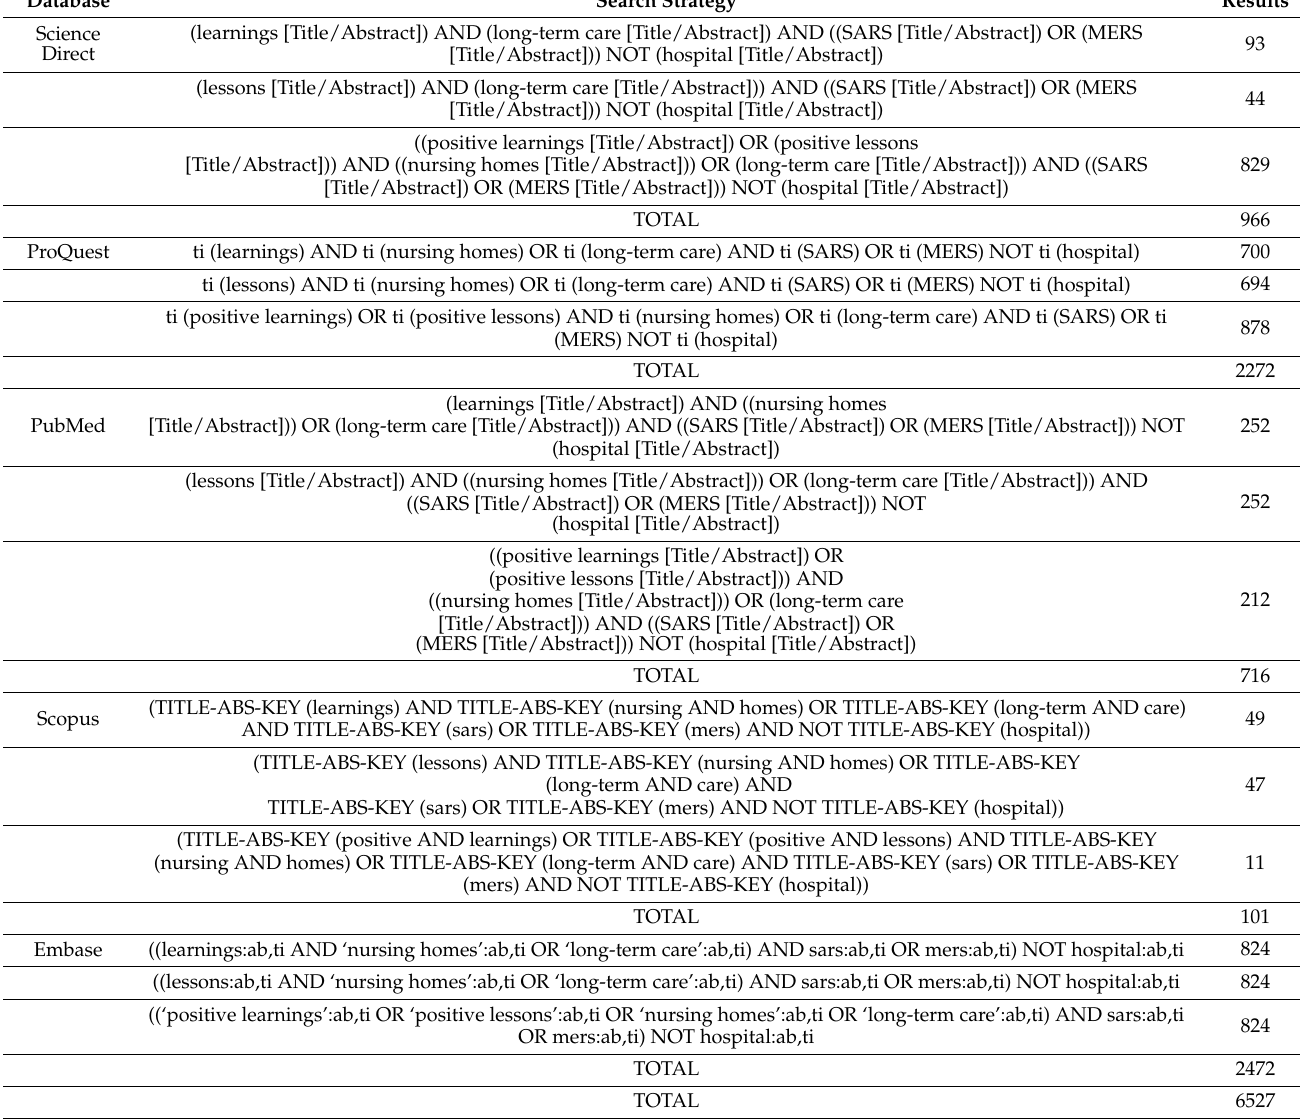
Table 1. Search strategies for each